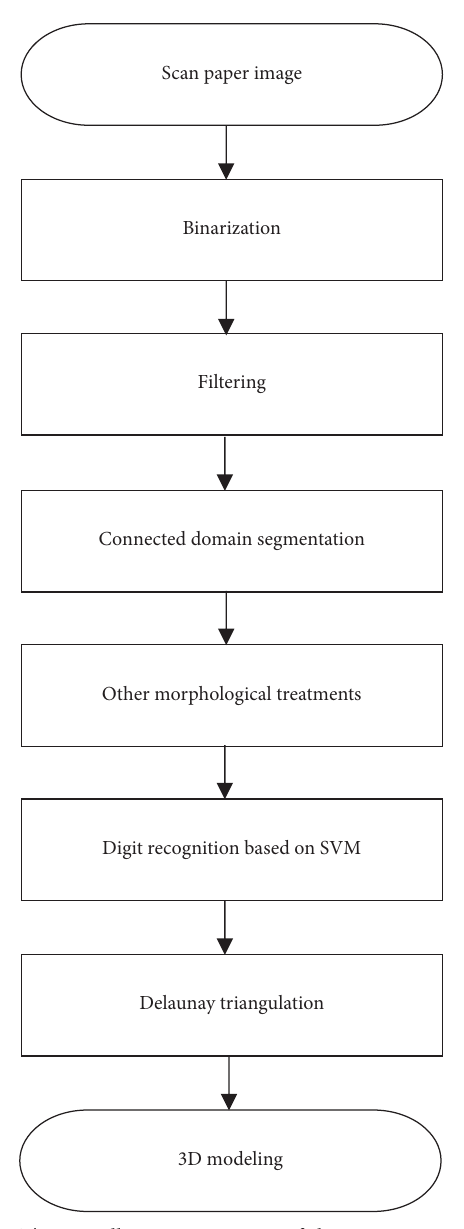
Figure 1: Te overall processing steps of the papery contour